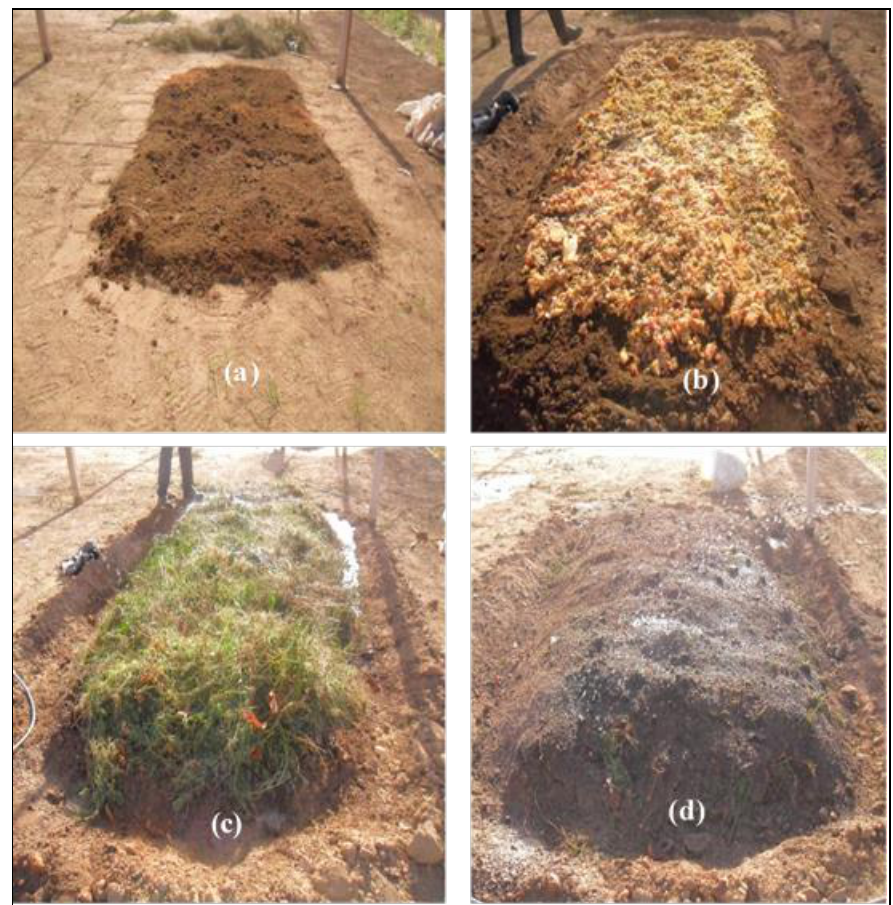
Figure 4: (a) First layer of organic material being prepared (black soil + manure + sawdust); (b) Second layer of material used for the preparation of compost (food waste); (c) Third layer of the material used for the preparation of organic compound (plant residues); (d) Fourth and final layer of material composting, again adding black